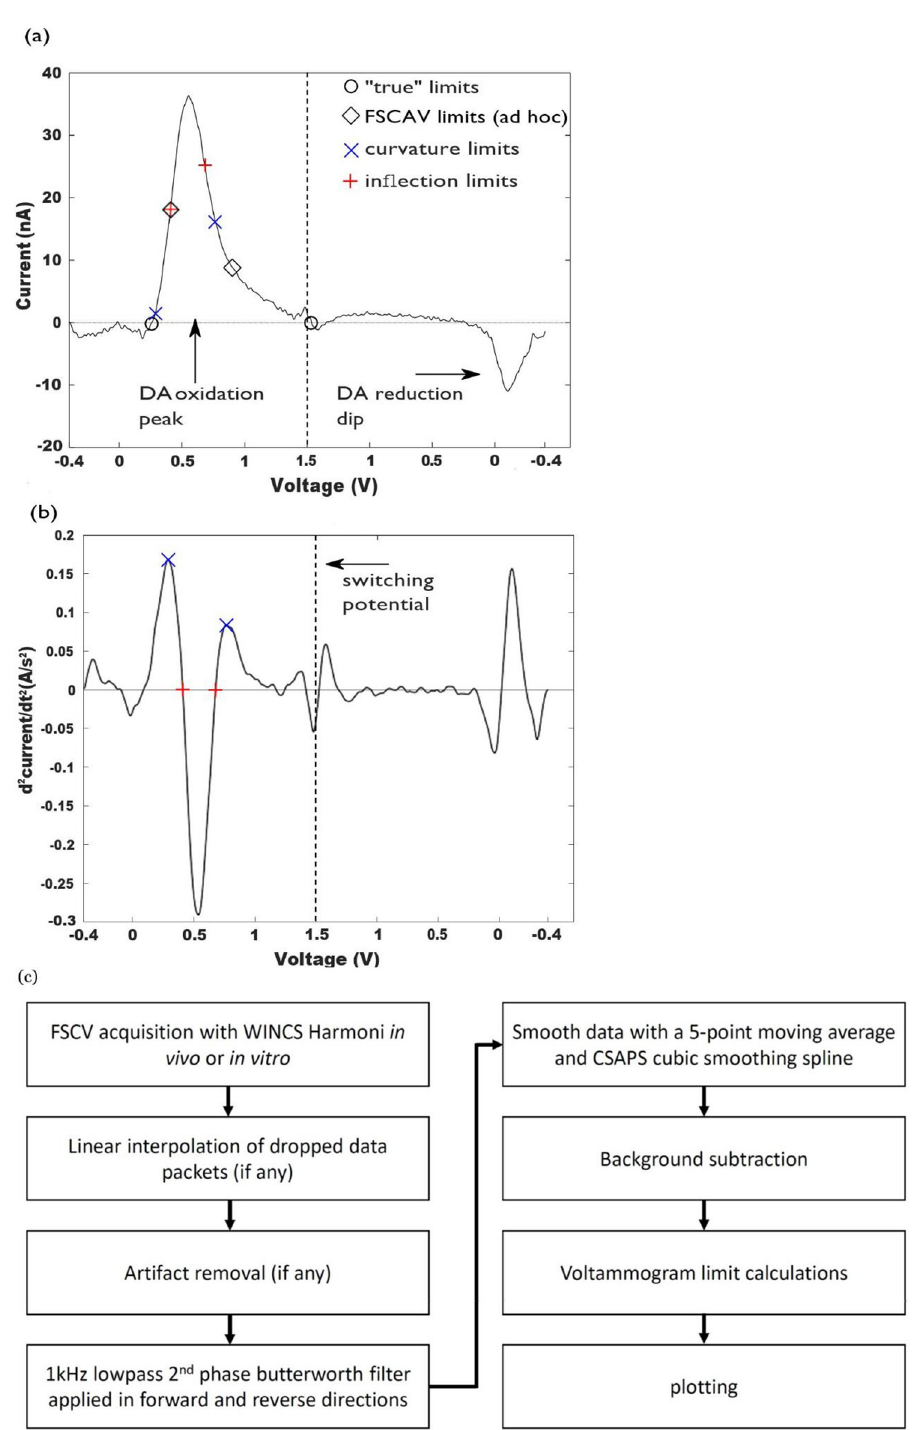
Fig 1. a) Background subtracted voltammogram for a bolus of a 0.5 μ M dopamine solution. True (“o”, x l = 0.26 V and x r = 1.5 V), FSCAV (“ ♦ ”, x l = 0.4 V and x r = 0.9 V), inflection (“+”, x l = 0.41 V and x r = 0.68 V) and curvature integration boundaries (“x”, x l = 0.29 V and x r = 0.76 V) are marked on the voltammogram. b) Second derivative of the voltammogram shown in (a), showing the definition of inflection boundaries (inflection points), and curvature boundaries (the maxima around the location of the oxidation peak). c) Flow chart demonstrating overview of applied computational procedures to raw FSCV data.